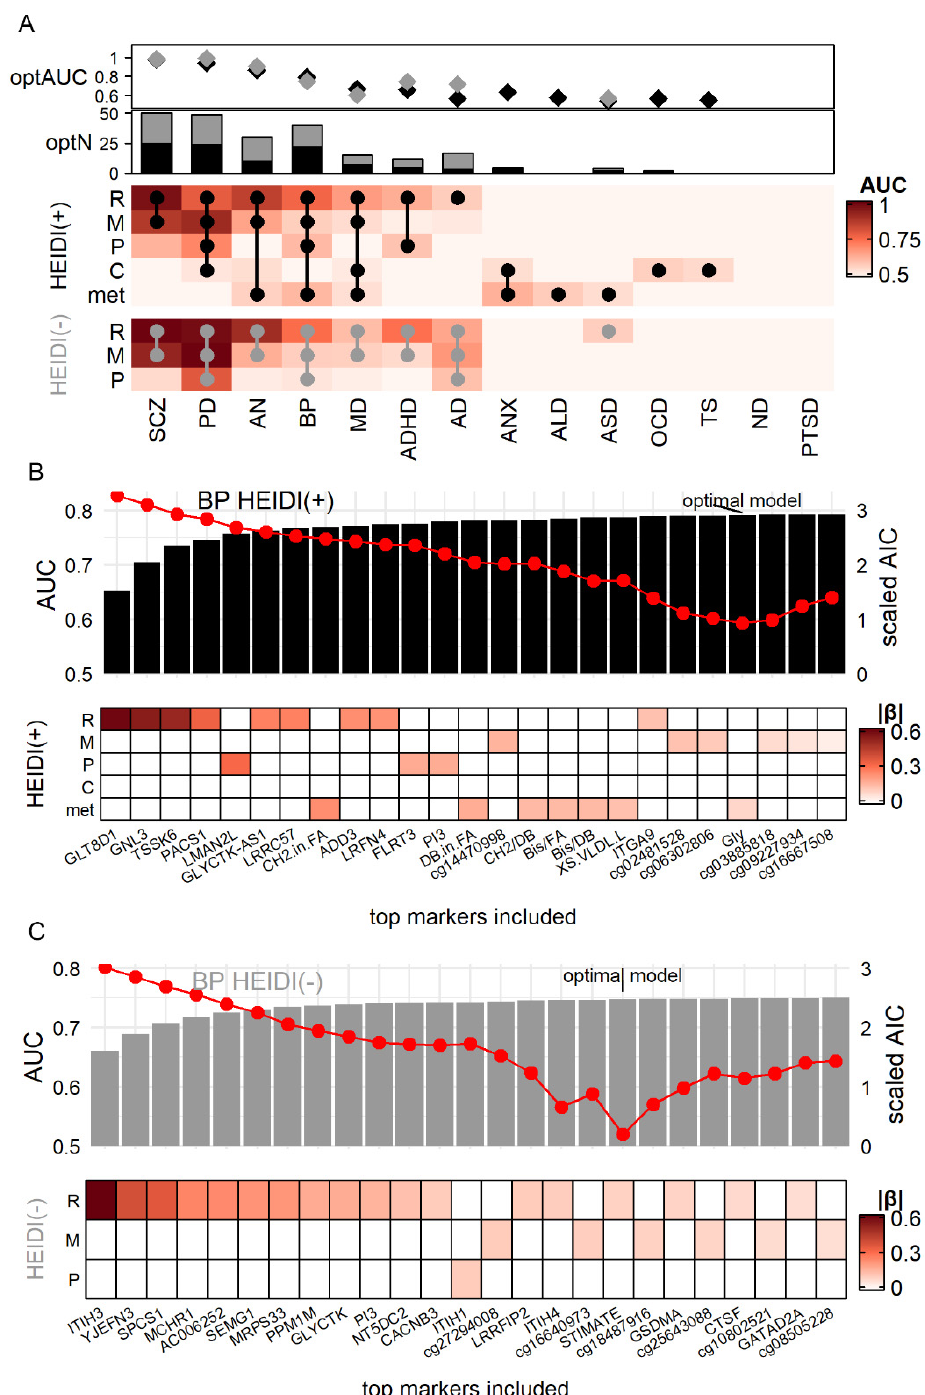
Figure 3. Comparison of biomarker efficiency among diseases and omics in simulation. ( A ) Each grid of the heatmap showed the Area Under Curve (AUC) of the model consisting of all markers from one omic for one disease. Dots on the heatmap showed the composition of the optimal model with the lowest Akaike information criterion (AIC). Diamonds (optAUC: AUC for optimal model) and bar plots (optN: number of markers in optimal model) showed the AUC and number of markers of the optimal models (black for HEIDI(+) model, grey for HEIDI( − ) model). ( B , C ) example optimal model of BP. Red dots denoted AIC. R: RNA. M: methylation site. p : protein. ( C ) cytokine. met: metabolite. | β |: absolute value of β